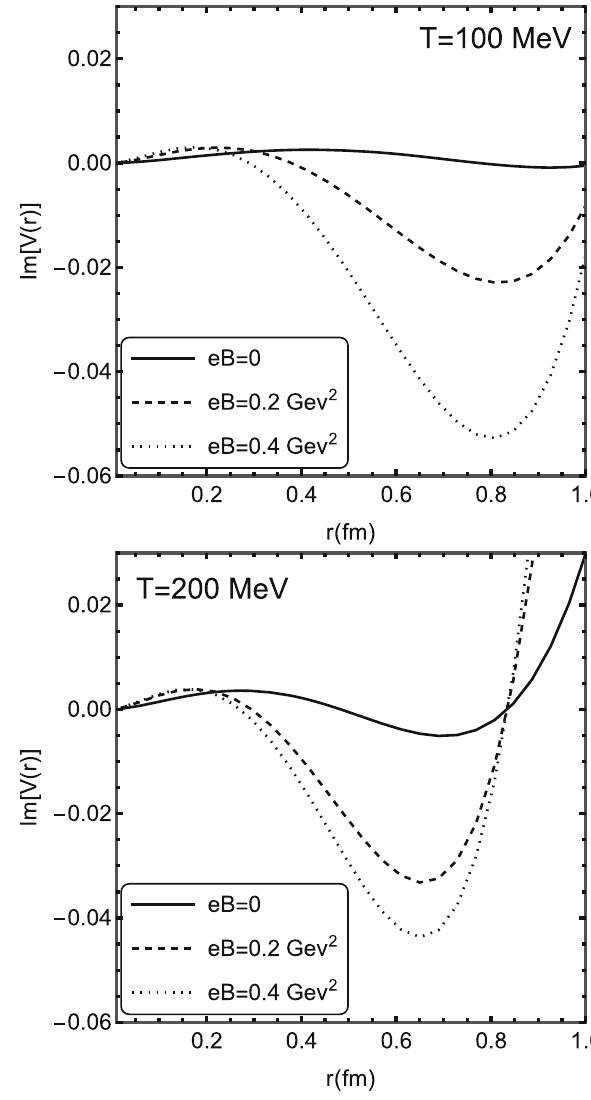
Fig. 4 Variation of the imaginary part of potential with separation dis- tance r between Q ¯ Q for various values of magnetic field T = 100 MeV (left) and T = 200 MeV